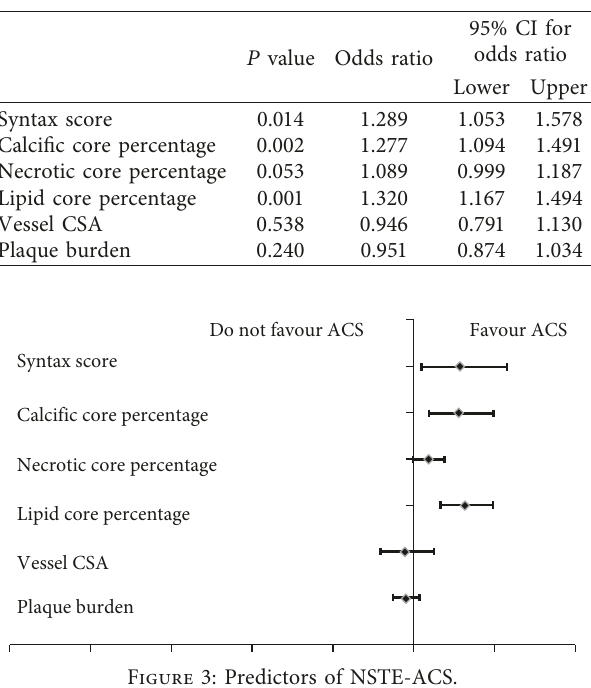
Figure 3: Predictors of